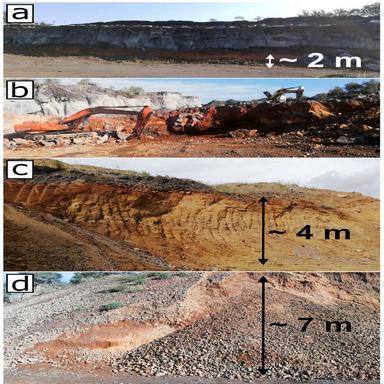
Ghiara layers outcropping in the area of Belpasso beneath Etnean historic lavas. Outcrops display thickness of 2 m in "Bernav`e" (a), 3 m in "Timpa di Pero" (b), and 4 m in "Incaria" (c) quarries. The maximum thickness is shown by the Ghiara outcrops at the "Perniciano" quarry (d), where they reach 7 m.